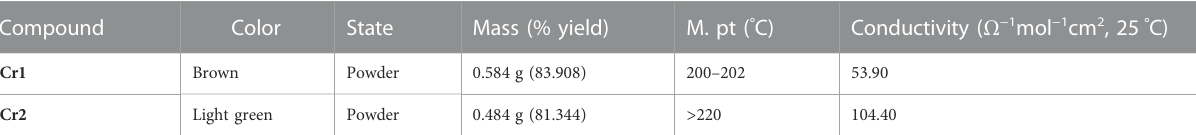
TABLE 1 Physicochemical properties of the synthesized